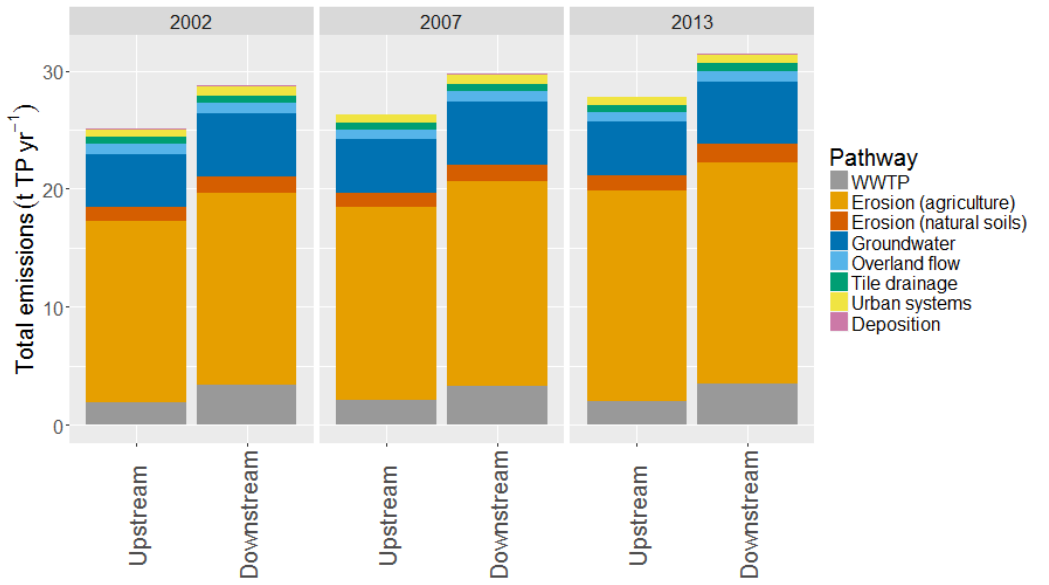
Figure 8. Total TP emissions and share of different pathways in the sub-catchments of the river Aschach modelled with MONERIS for the years 2002, 2007 and 2013.